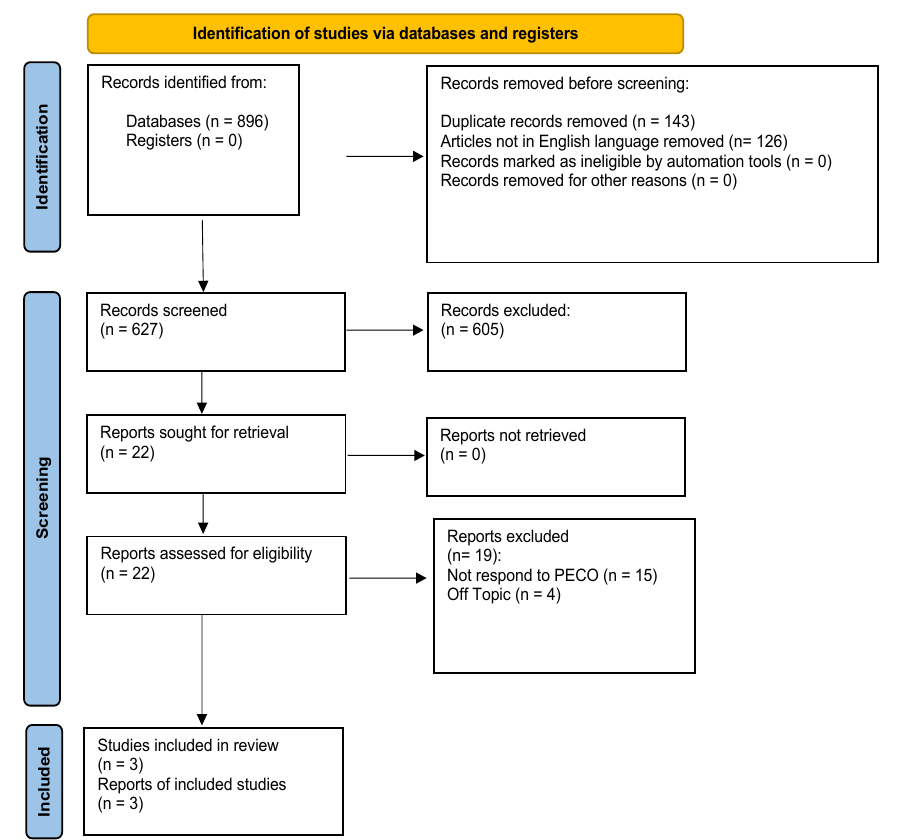
Figure 1. Prisma statement. From: Page, M.J.; McKenzie, J.E.; Bossuyt, P.M.; Boutron l Hoffmann,